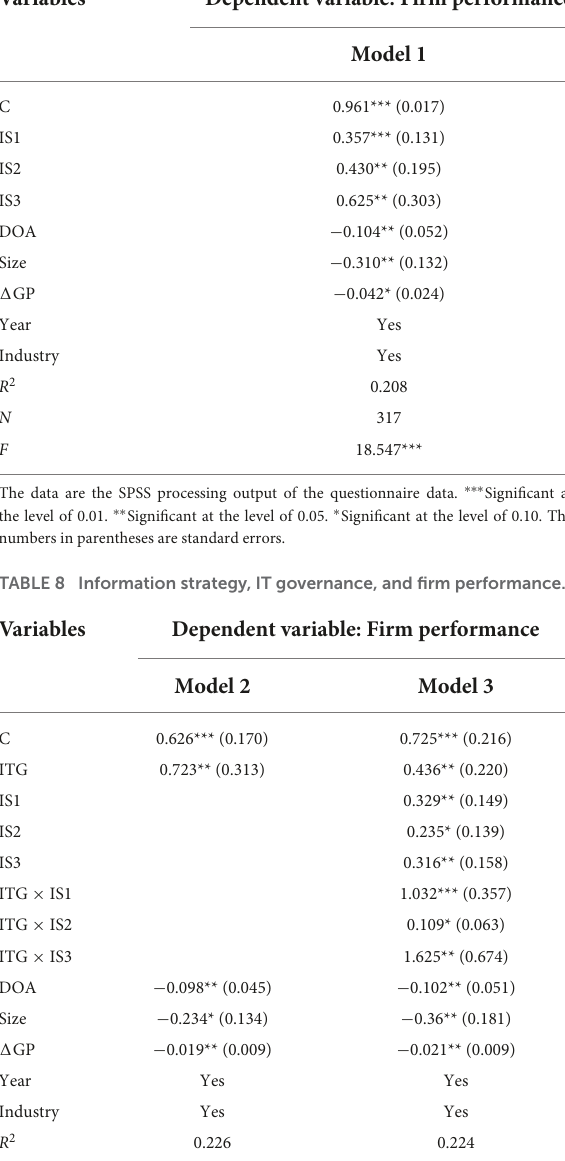
TABLE 7 Information strategy and firm performance.